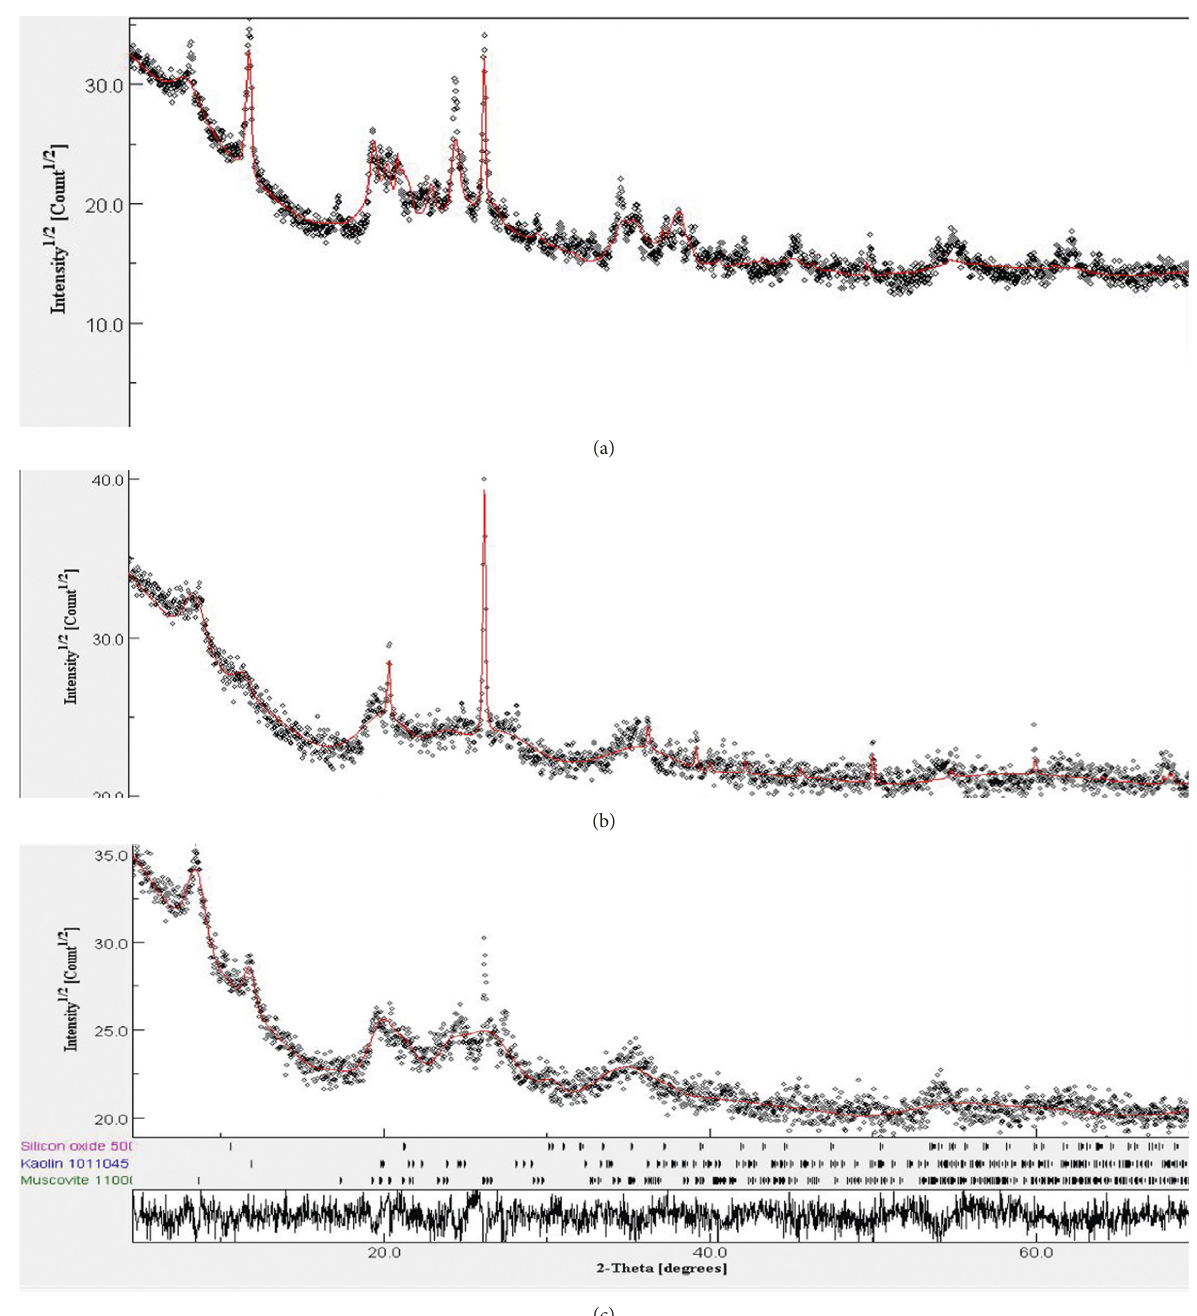
Figure 1: Powder X-ray diffraction pattern of the clay samples. (a) C1, (b) E1, and (c)